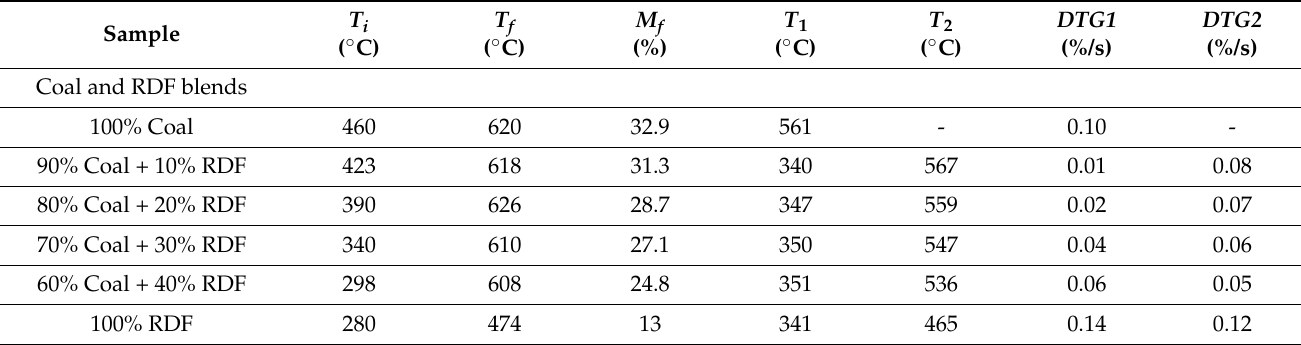
Table 2. The co-combustion characteristics parameters of coal, RDF, and their blends at heating rate 10 ◦ C/min.